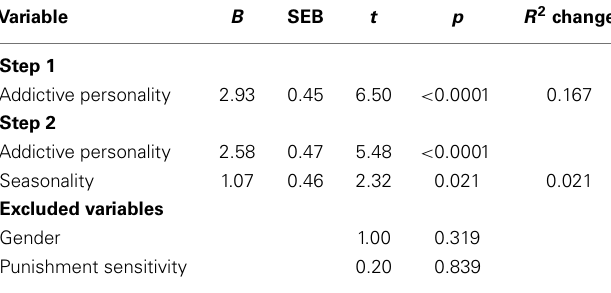
Table 2 | Hierarchical regression analysis summary ( n = 211) for the independent variables (punishment sensitivity, addictive personality, seasonality, and gender) predicting the dependent variable (addictive